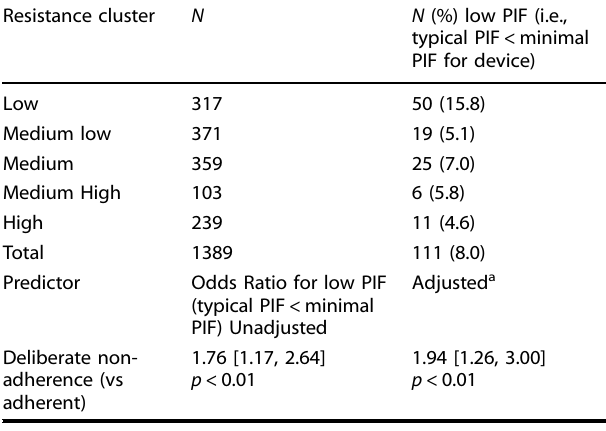
standardized protocols, the multi-country setting may have introduced heterogeneity in our data. Given our decision tree (Fig. 2), it should be acknowledged that matching the DPI to the patients ’ needs should not be solely based on PIF, but that